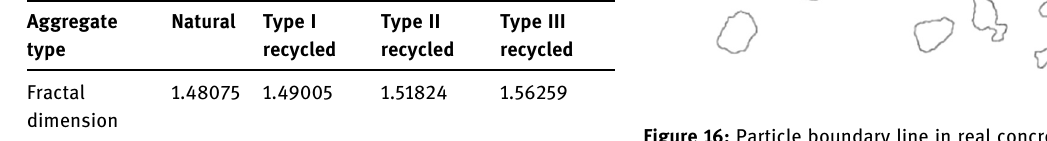
Figure 16: Particle boundary line in real concrete